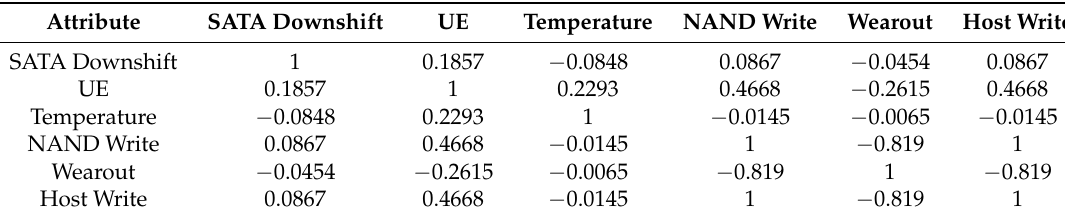
Table 10. Kendall Correlation